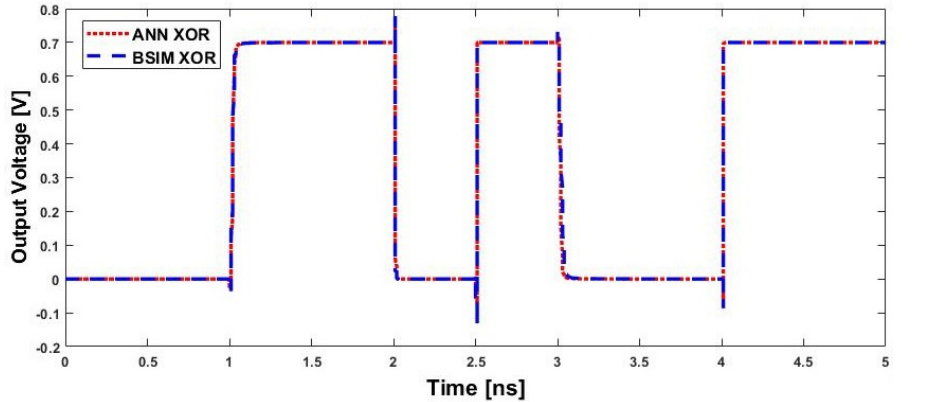
Figure 9. Comparison of the ANN model and the BSIM-CMG model for the XOR simulation.